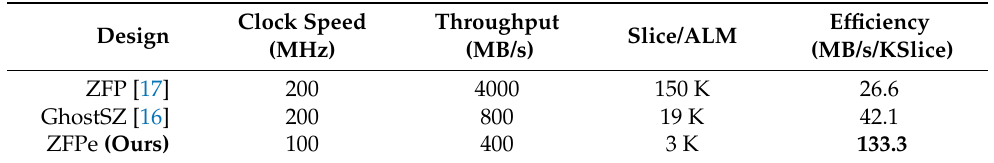
Table 2. Performance efficiency comparison of compression